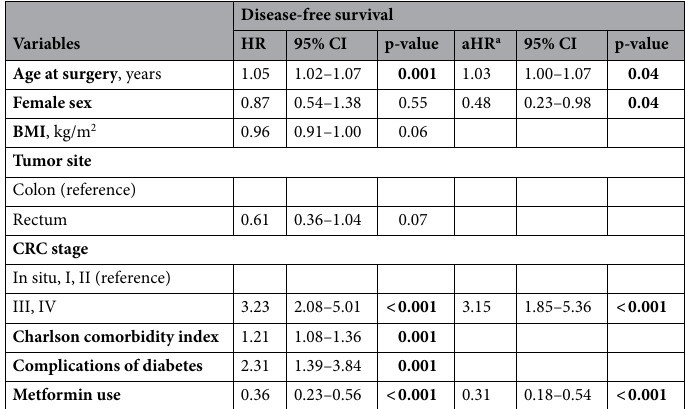
Table 4. Disease-free survival assessed by the Cox regression model. Significant values are in bold. HR, hazard ratio; CI, confidence interval. a Adjusted for age at surgery, sex, BMI, tumor site, CRC stage, Charlson comorbidity index, diabetes complications.